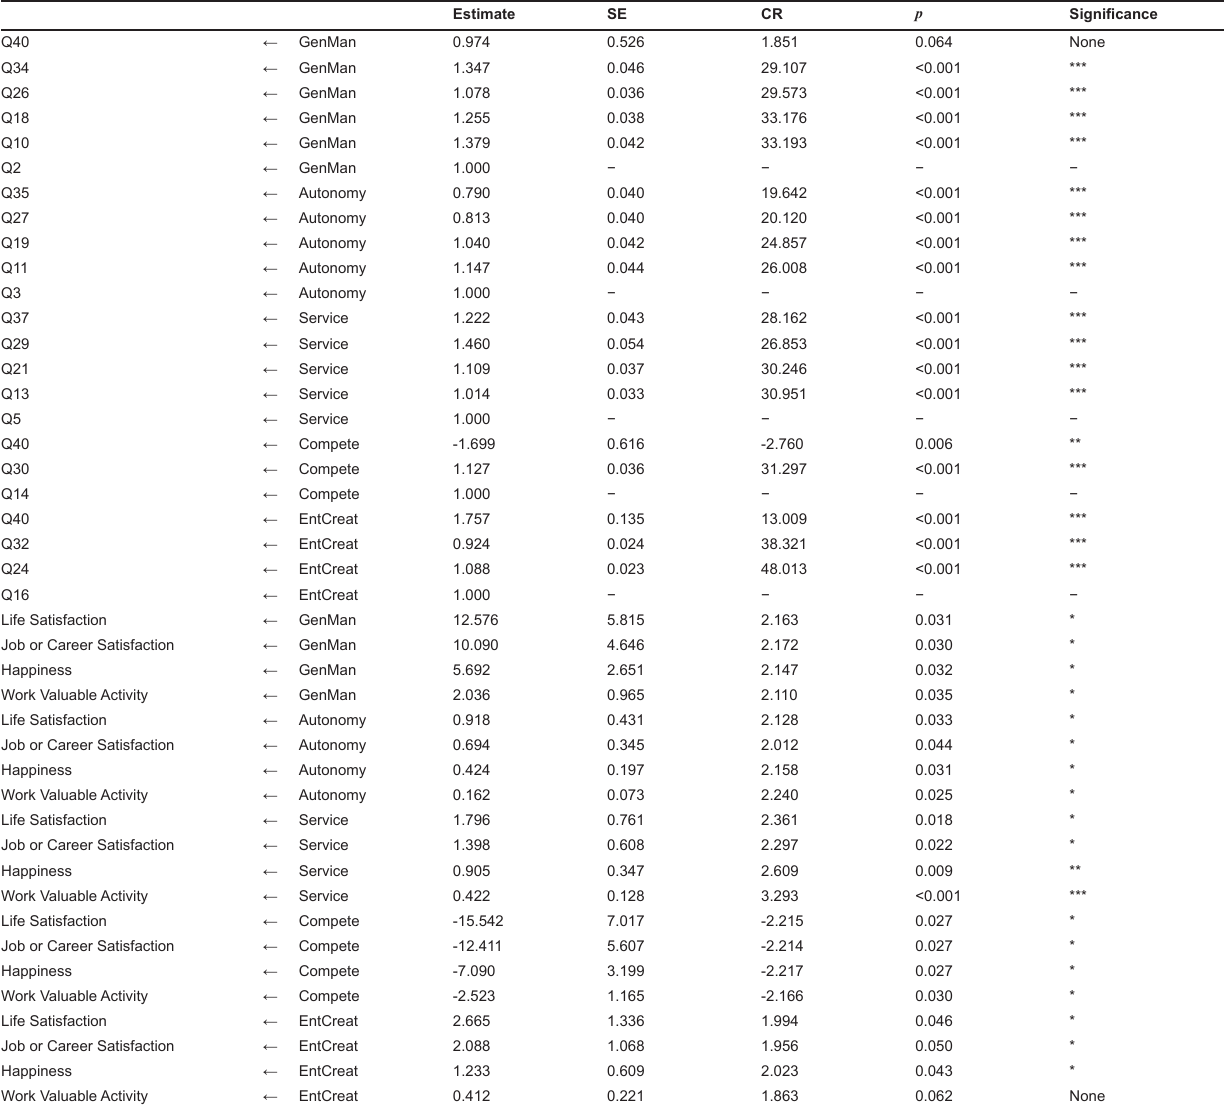
Estimate CR p Significance